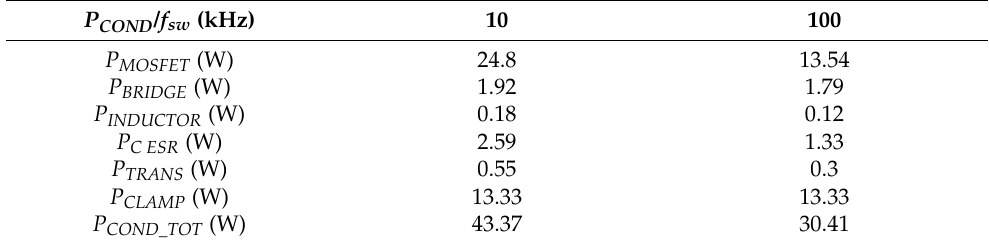
Table 3. Distribution of conduction power losses P IN = 300 W.